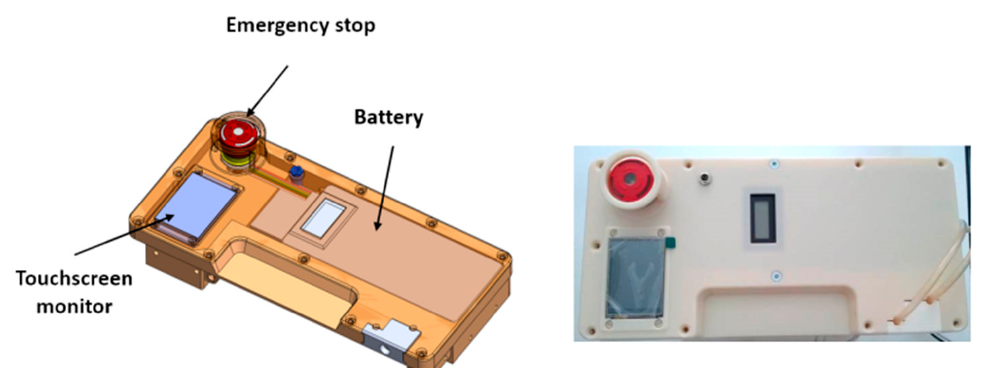
Figure 5. Covering panel on the top face of the RAP: 3D sketch and manufactured prototype.